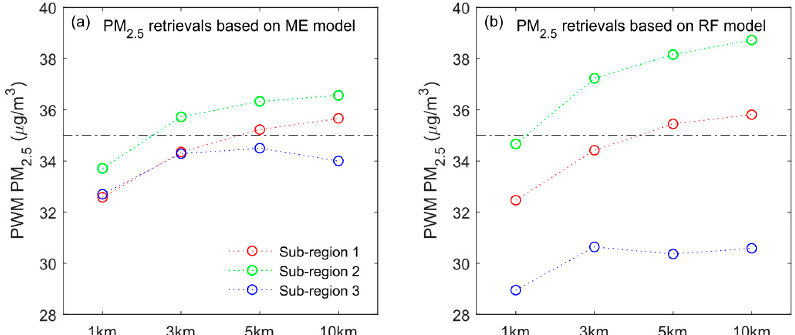
Figure 10. Annual population-weighted mean (PWM) PM 2.5 as a function of spatial resolution. Panels ( a , b ) are based on PM 2.5 retrievals from the mixed effects (ME) and Random Forest (RF) models. Red, green and blue lines in each panel stand for sub-region 1 (northeast YRD), sub-region 2 (northwest YRD) and sub-region 3 (southern YRD), respectively. See Figure 1a for different sub-regions.